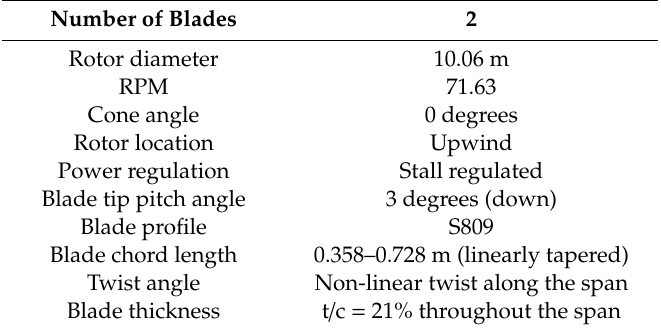
Table 1. NREL Phase VI Sequence H blade description. Data source: NREL blade design, 2020